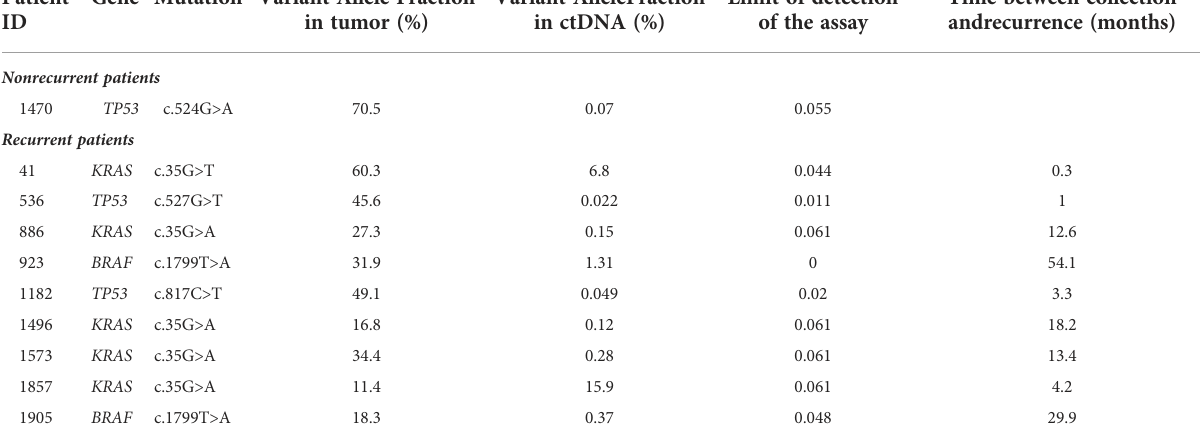
TABLE 2 Mutations and variant allele fractions detected in post-operative ctDNA+ patients. Patient